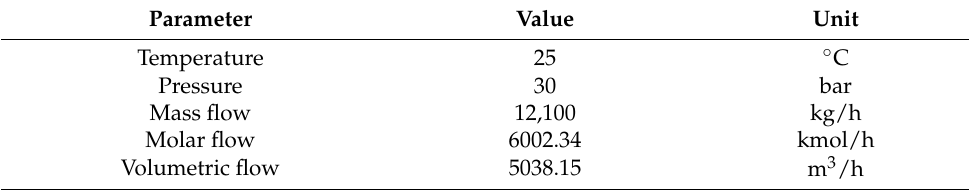
Table 2. Input flow’s conditions (H 2 )